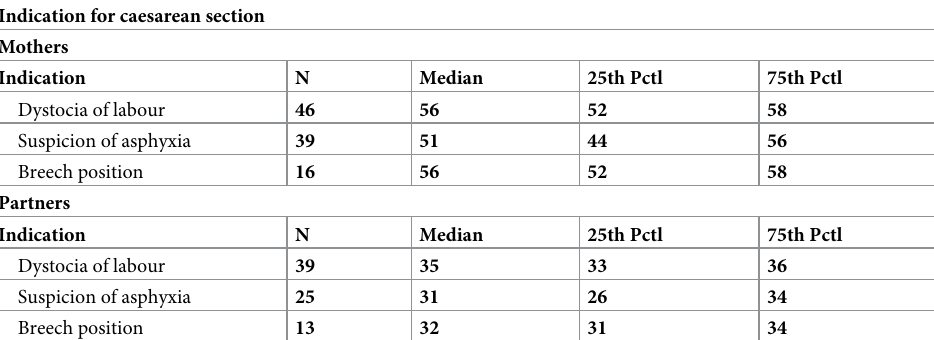
Table 6. Association between indication of caesarean section and perceived quality of care measured as median questionnaire scores by mothers and partners Legend: The results represent sum-score values of perception of care reported in the questionnaires ranging from zero to 60. Pctl: